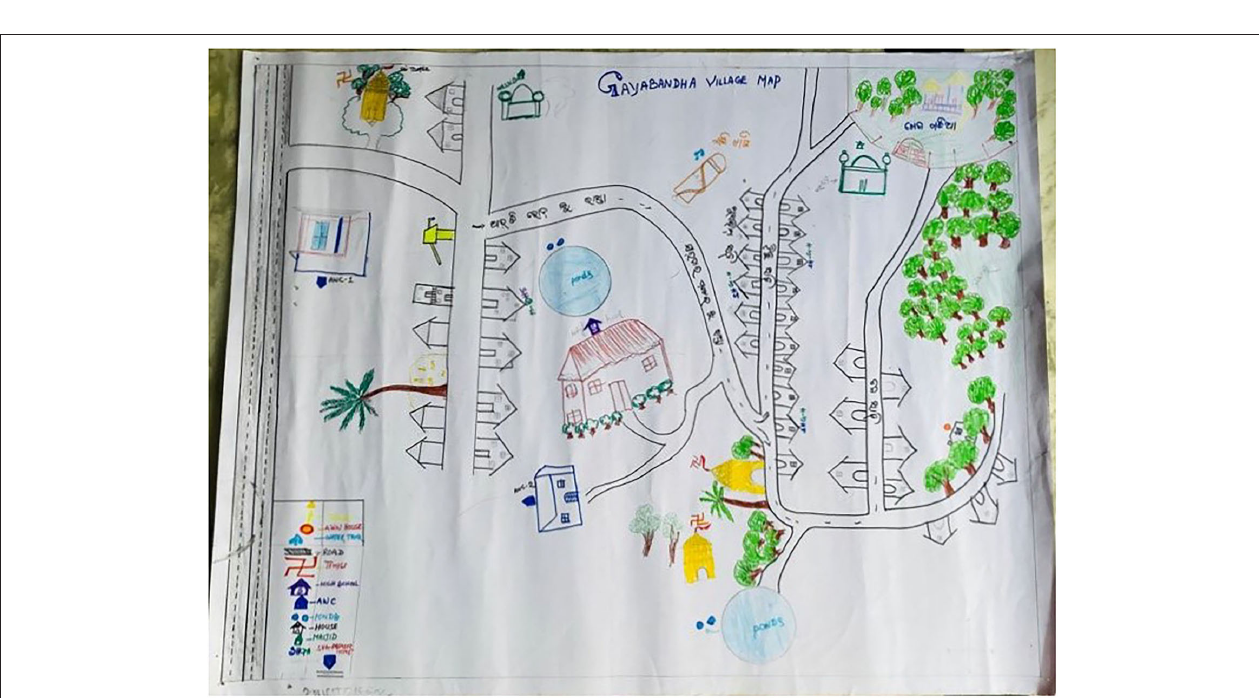
FIGURE 4 | Resource map of a village.